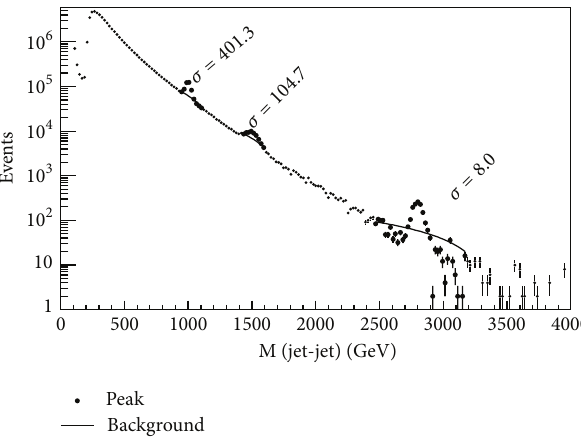
Figure 2: Invariant mass of two jets generated with the PYTHIA Monte Carlo model. Several peaks seen in this figure were added using the Gaussian distributions with different widths and peak values (see the text). The peaks are found using the NPFinder algorithm which also estimates their statistical significance values as discussed in the